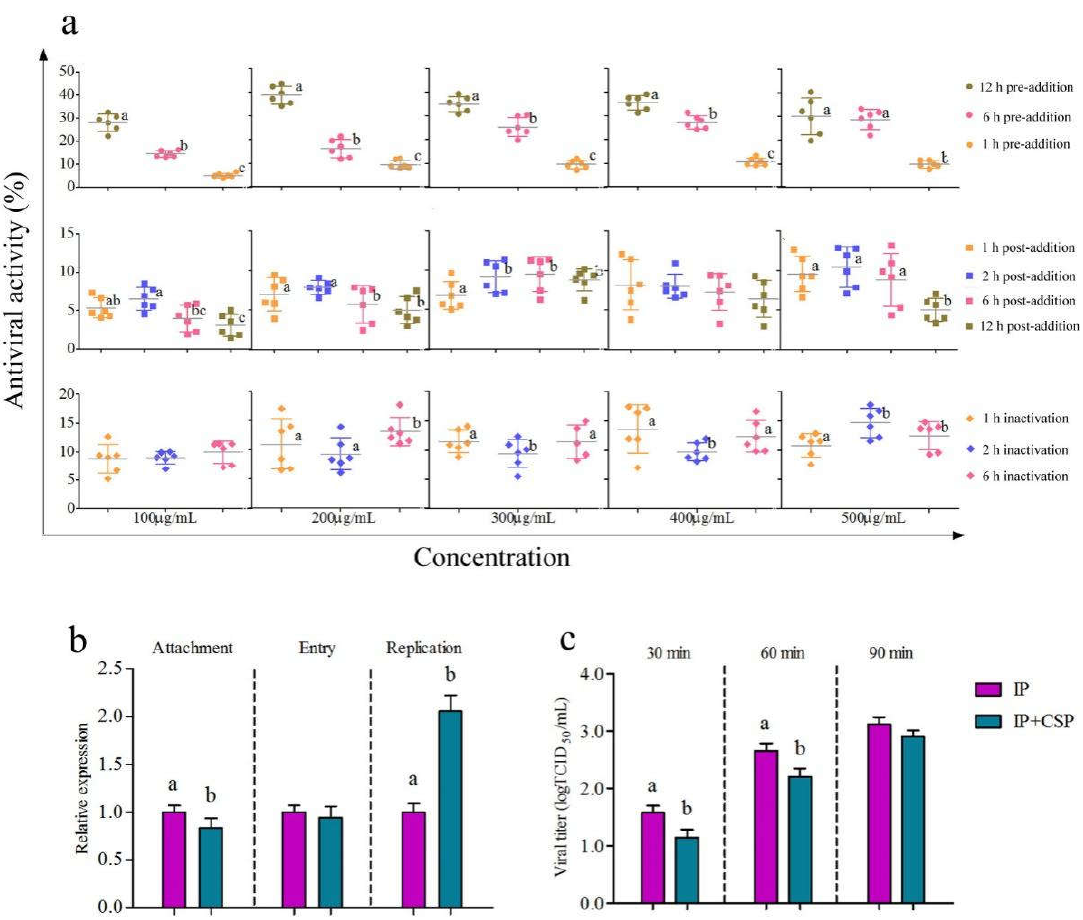
Figure 4. The antiviral activity and actions of CSP on IPNV. ( a ) The antiviral activity of CSP with different concentrations on IPNV under the pre-addition, post-addition, and inactivated treatments. ( b ) The changes in relative expression levels of the IPNV-VP2 gene in the viral attachment, entry, and replication processes, respectively. ( c ) The determination of the viral titers during the viral release process. Different letters indicate statistical significance, p < 0.05.